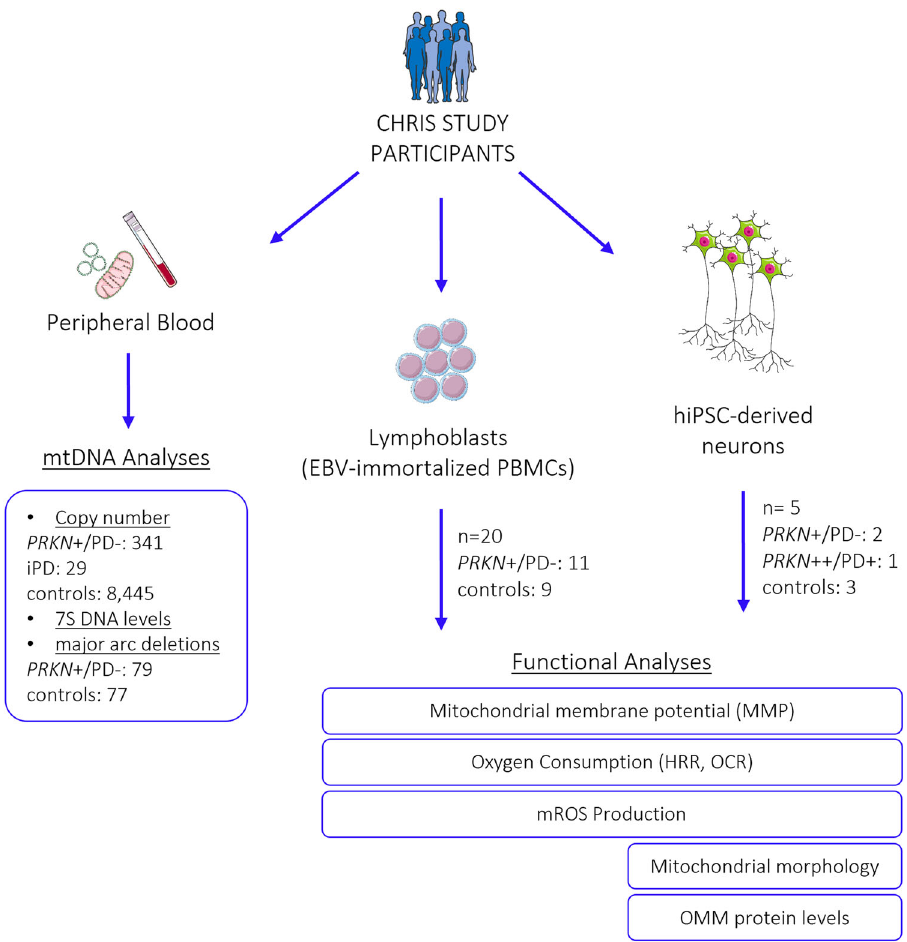
Fig. 1 Experimental design. Flow chart indicating study participants, biospecimens, and performed experiments. PBMCs peripheral blood mononuclear cells, EBV Epstein Barr Virus, mtDNA mitochondrial DNA, LCLs lymphoblastoid cell lines, MMP mitochondrial membrane potential, mROS mitochondrial reactive oxygen species, OMM outer mitochondrial membrane. PRKN + /PD − : individuals carrying a heterozygous variant in PRKN ; PRKN ++ /PD + : PD patient with a homozygous variant in PRKN ; iPD: patient with idiopathic PD. Details on study participants are available